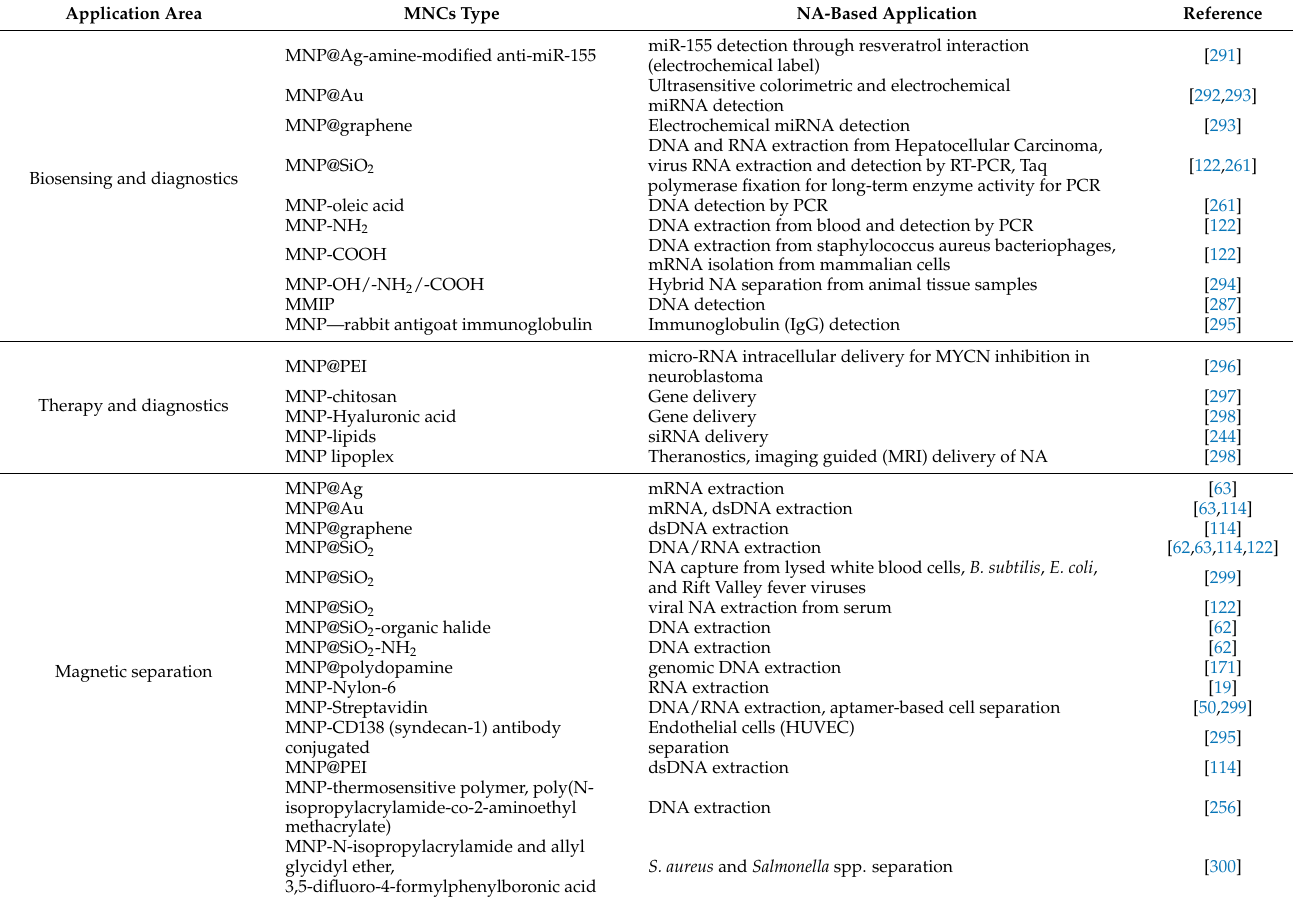
Table 1. Some examples of nucleic acid-based biomedical applications of